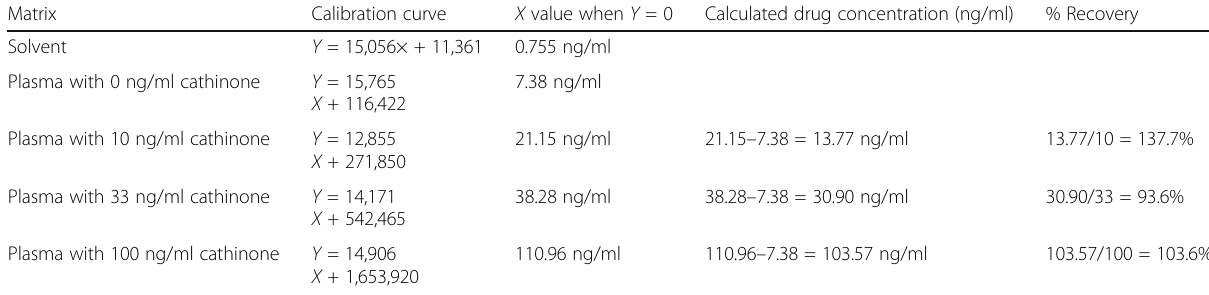
Table 1 Accuracy of quantifying cathinone in plasma using standard addition method Matrix Calibration